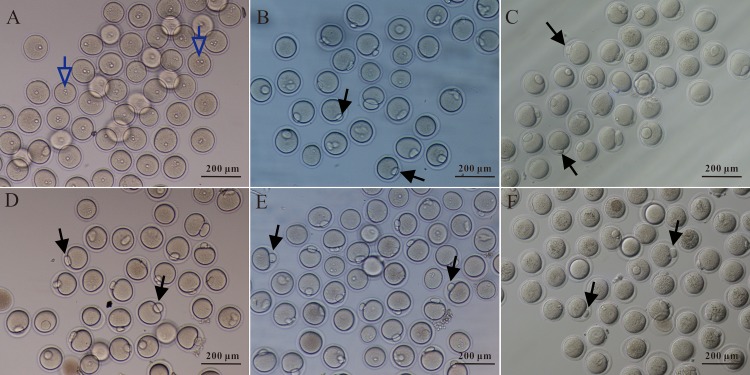
Effects of NaBu on the maturation of GV stage oocytes in vitro.Mouse GV stage oocytes were isolated (A) and cultured in KSOM supplemented with NaBu at different concentrations in vitro. Representative pictures of oocytes cultured for 14 h in KSOM supplemented with 0.1 mM (B), 0.5 mM (C), 1.0 mM (D), 5.0 mM (E), and 10.0 mM NaBu (F). Hollow arrows indicate the germinal vesical. Black arrows indicate the first polar body. Scale bars: 200 μM.